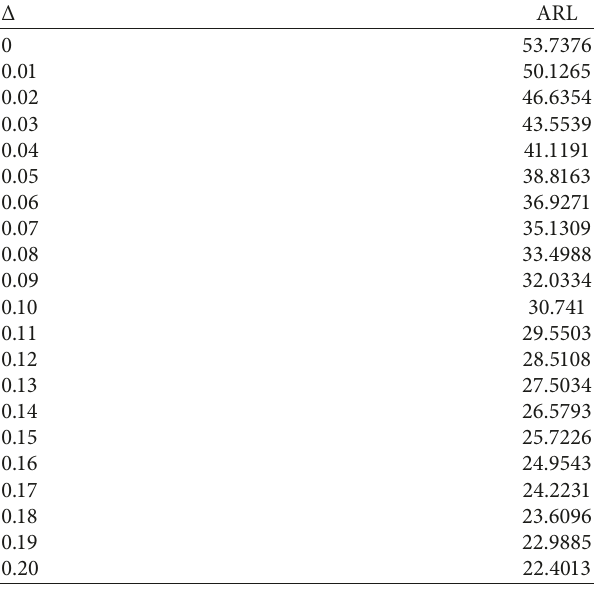
� 2, ϕ � 1, and h � 3. 1